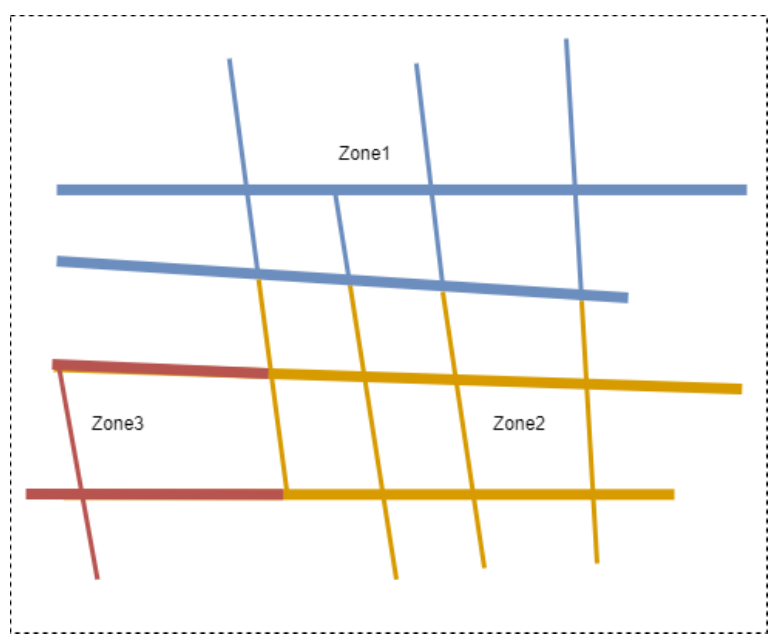
Figure 4. A spatial Voronoi diagram showing the road network for three emergency